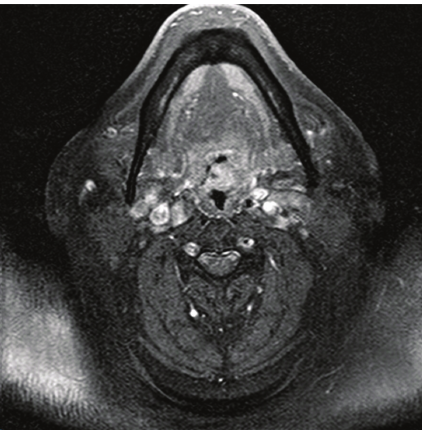
Figure 1: Axial T1 weighted contrast-enhanced MRI image shows left oropharyngeal mass.